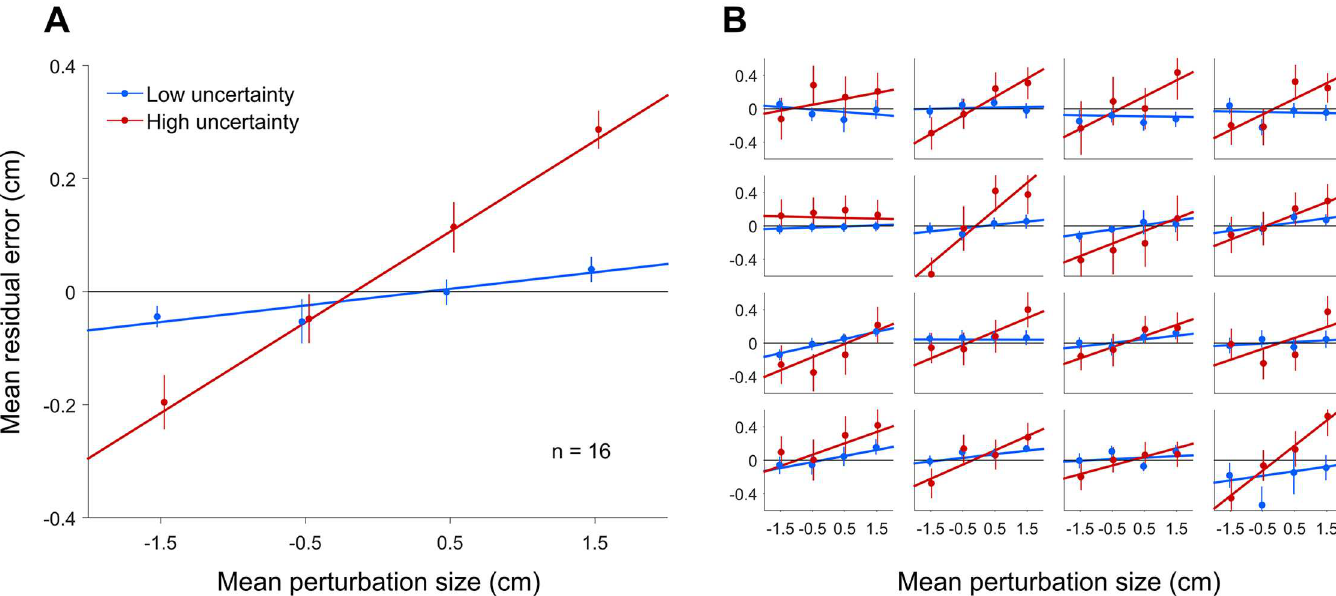
Fig 2. Mean residual error against mean perturbation size, for Low-uncertainty (blue) and High-uncertainty (red) trials. A: Group mean residualerror againstmean perturbationsize. Error bars are SEM betweensubjects. Fits are are linear regressions to the mean data. B: Each panel reports the mean residualerror against mean perturbationsize for a single subject, for Low-uncertainty (blue) and High-uncertainty (red) trials. Error bars are SEM between trials. Fits are linear regressionsto the individualdata. For both panels each subject’s data have been shifted so as to remove the mean residualerror for the 0 perturbationconditionfor that